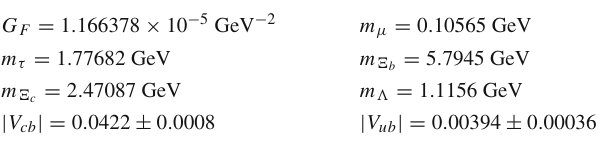
anomalies within 2 σ range of their corresponding experimental L Table 2 Input parameters in the SM used for our numerical analy- sis